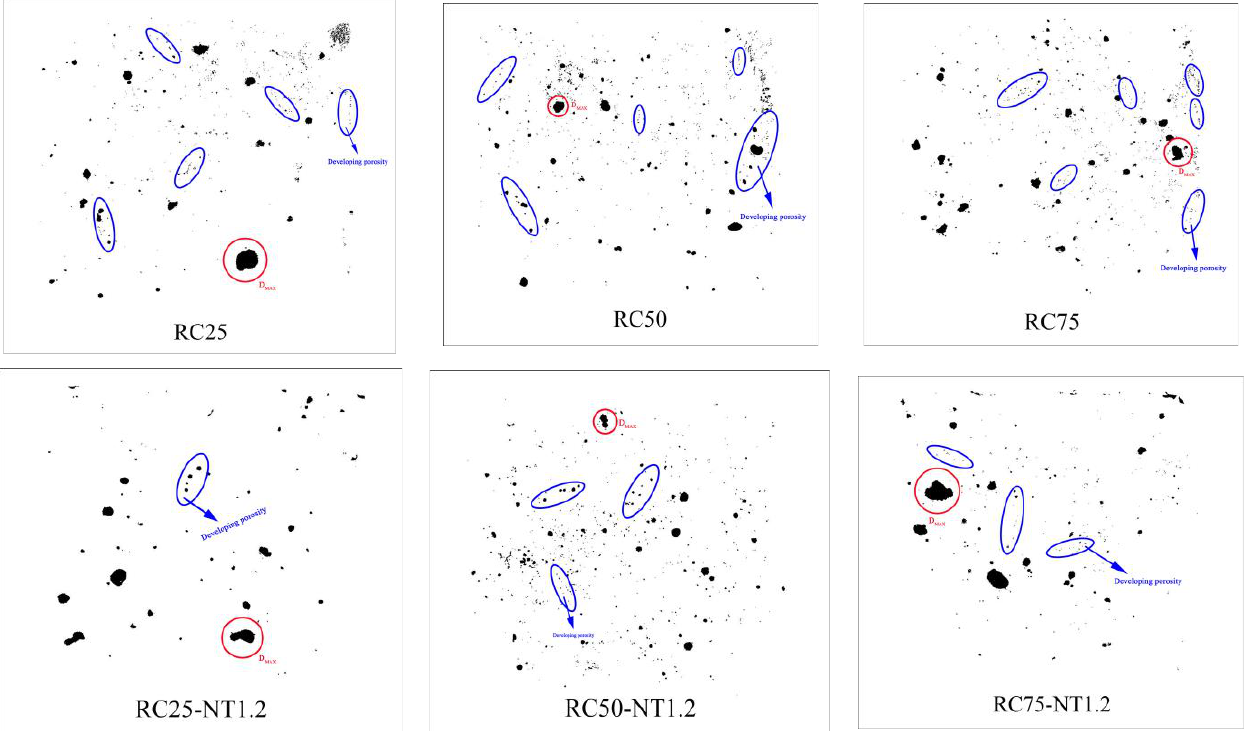
Figure 8. Macroscopic pore diagram of recycled aggregate concrete without freeze – thaw.